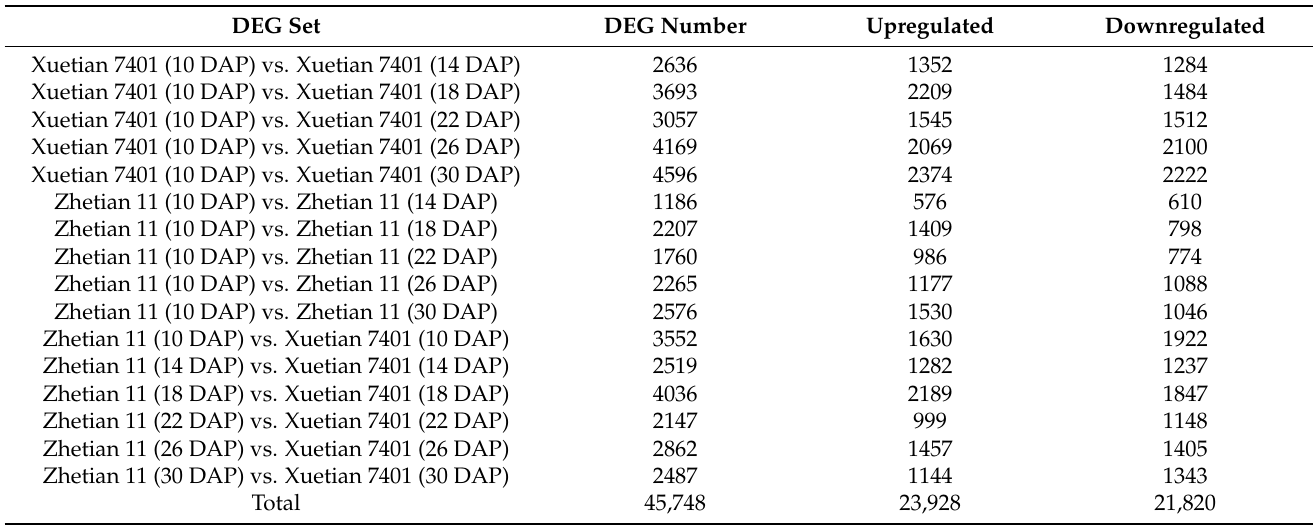
Table 2. Statistical table of the DEG numbers of developing kernels.